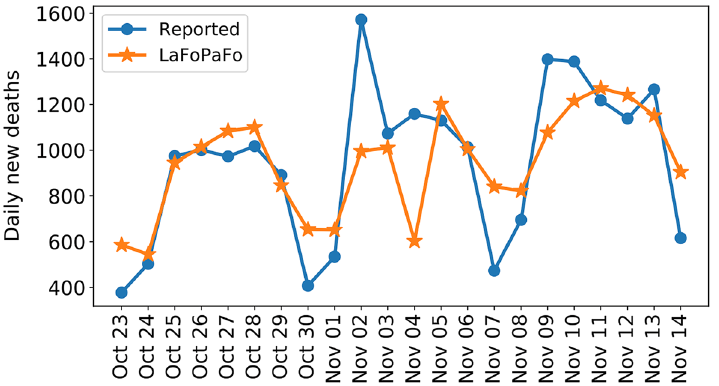
Figure 5. LaFoPaFo’s daily forecasting results for the future 14-day number of deaths in the USA. LaFoPaFo forecasted each day from September 20 to October 10, 2020, 2 weeks ahead. LaFoPaFo forecasts the periodicity in the daily data as well as the peak values with at most one day delay.